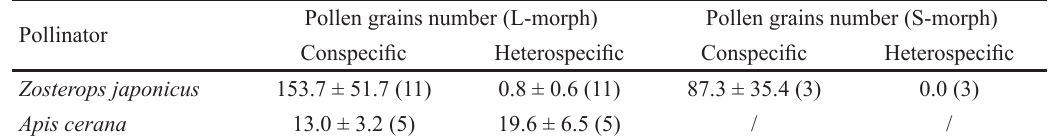
Table 3 – The number of pollen grains (conspecific pollen and heterospecific pollen) deposited on the stigmas of C. subcordata after a single visit from Z. japonicus or A . cerana on Yongxing Island.